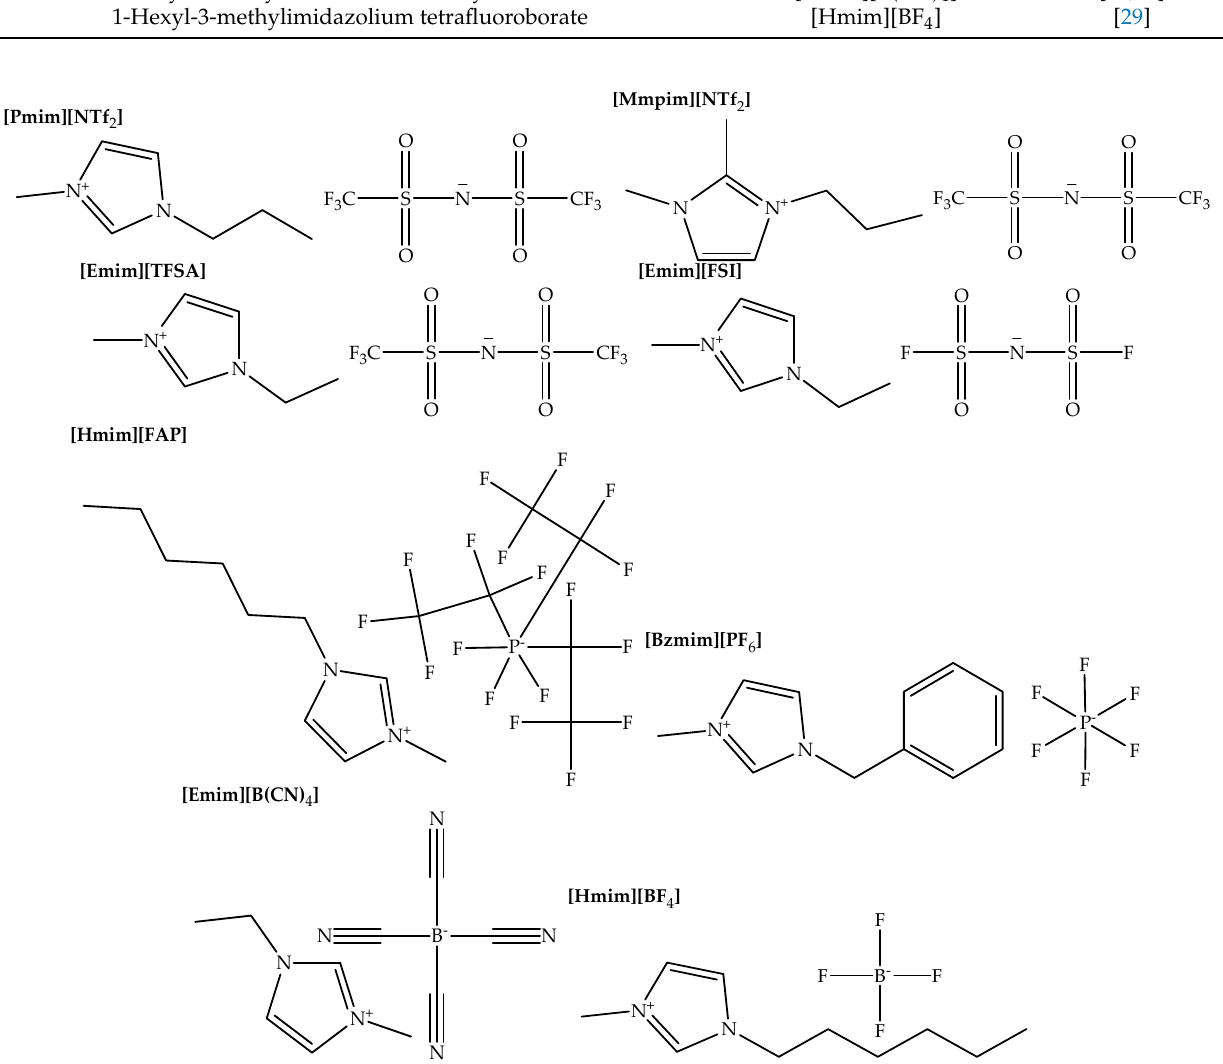
Figure 4. Chemical structures of hydrophobic imidazolium-based ionic liquids and the abbreviations are explained in Table 2. Table 3 displays examples of fillers modified with imidazolium-based ionic liquids for preparation of PVDF and PVDF-HFP composites. It can be perceived that the allo- tropes of carbon, such as graphene, graphene oxide, and carbon nanotubes can be modi- fied with the ionic liquids [17,32,39]. Clay mineral like montmorillonite can not only be modified with surfactants [62,63] but also with the ionic liquids [10,15]. Additionally, metal oxides, for example, titanium dioxide and silicon dioxide have been modified with the ionic liquids [36,52]. On top of that, organic materials, for instance, polyvinyl pyrroli- done grains and succinonitrile have also been modified with the ionic liquids [31,37]. The utilization of the ionic liquids as modifiers can provide an advantage because of their ex- ceptional chemical structures that are able to interact with PVDF and PVDF-HFP, as well as inorganic and organic fillers. This consequently improves the interfacial bonding be- tween the polymer matrix and filler. In addition, to the best knowledge of the authors, no succinct review has been conceived encompassing the study on the preparations, proper- ties, and applications of PVDF/and PVDF-HFP/imidazolium-based ionic liquid blends and composites. That is the rationale of conceiving an organized review in this paper. Table 3. Examples of fillers modified with imidazolium-based ionic liquids for preparation of PVDF and PVDF-HFP composites. Filler